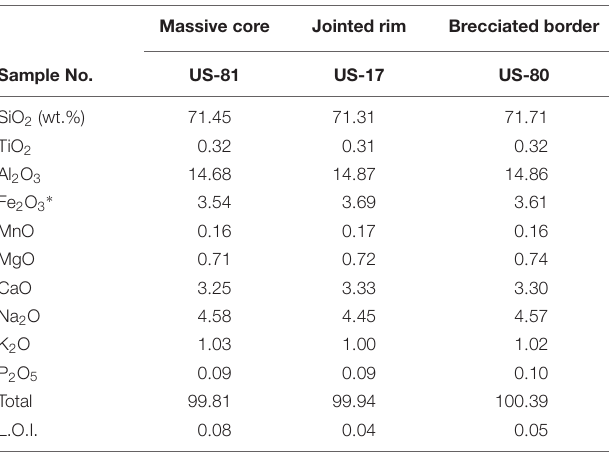
TABLE 1 | Whole-rock major element data for rhyodacites from the massive core, jointed rim, and brecciated border of the Ogariyama dome. Massive core Jointed rim Brecciated border Sample No.